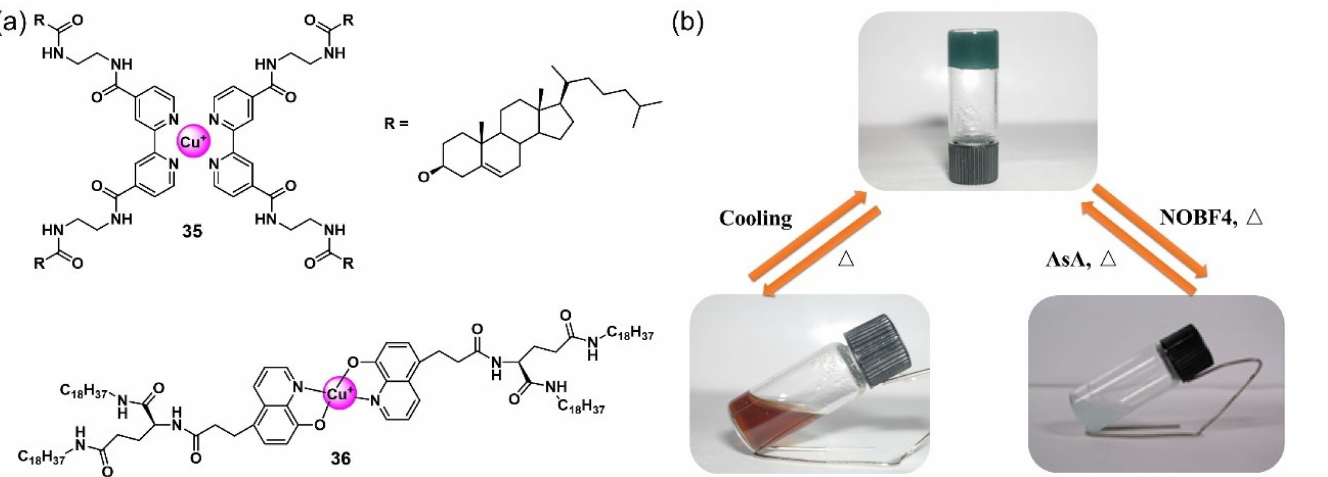
Figure 14. ( a ) Chemical structures of the gelators 35 and 36 . ( b ) Photographs of the chromatic change and phase transition behavior of 1-butyronitrile (1-PrCN) gel of 35 . Reprinted with permission from Ref. [65]. Copyright (2004), American Chemical